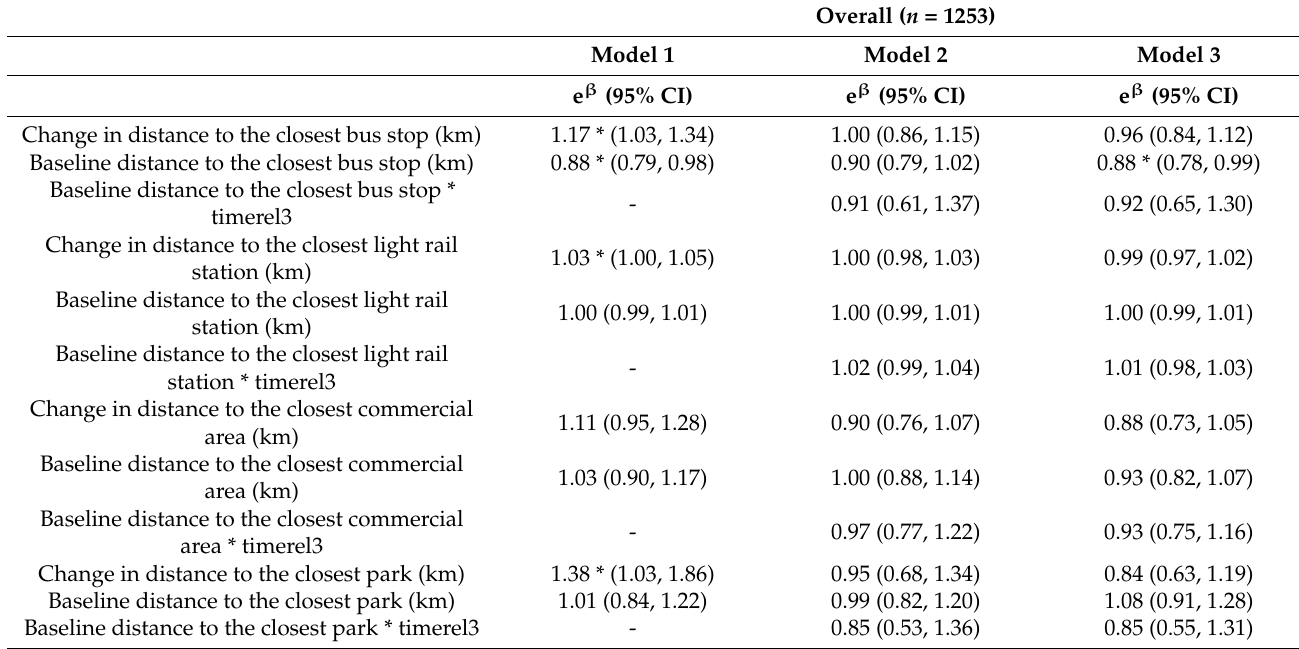
Table 3. Results for univariate and adjusted